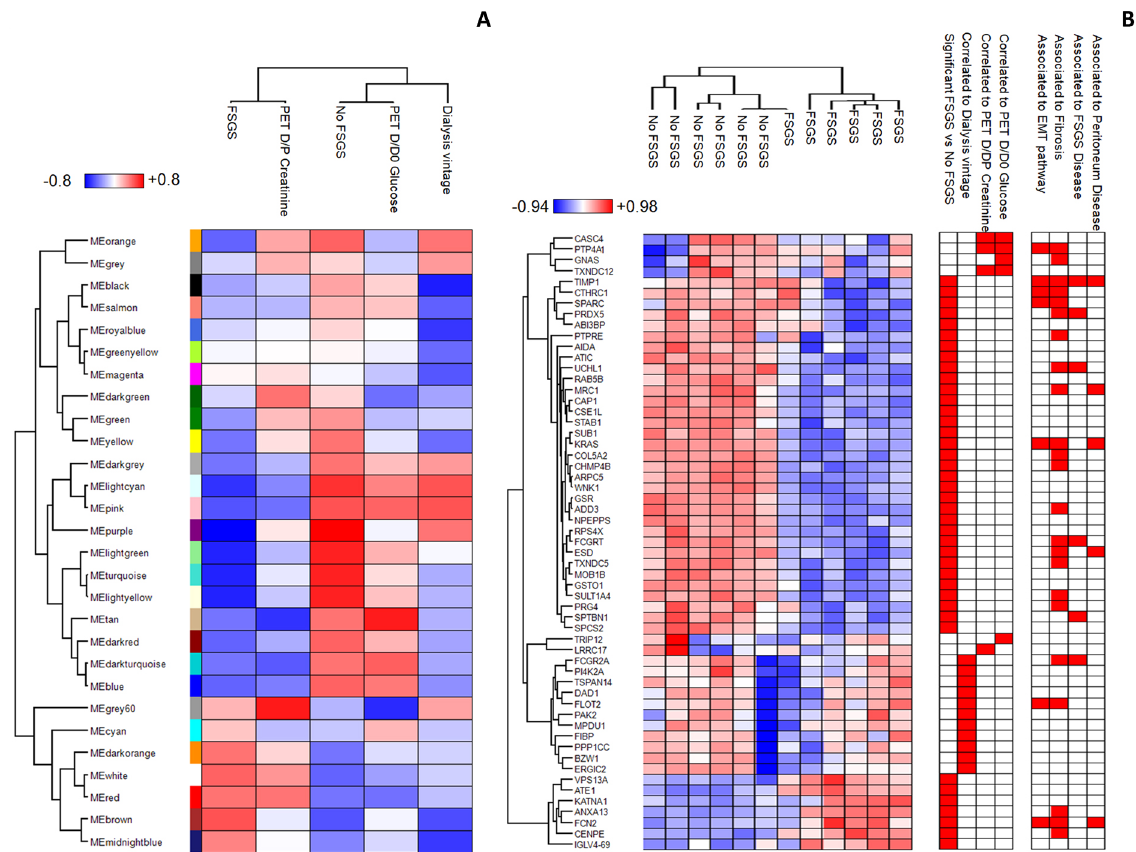
Figure 1. Weighted gene co-expression analysis of exosomes isolated from the peritoneal dialysis effluent of FSGS and No FSGS. ( A ) Heatmap of the correlation between module eigengenes and the clinical traits selected in the study. The grade of Spearman’s correlation coefficient ranged from − 0.8 (blue) to 0.8 (red). ( B ) Heatmap of 57 proteins in statistically significant correlation with at least one of the clinical traits selected in the study (Table 1). The correlation with each clinical trait is highlighted in red on the right of the